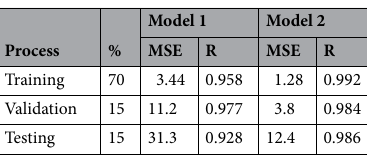
Table 4. Percentage, MSE, and R for ANN